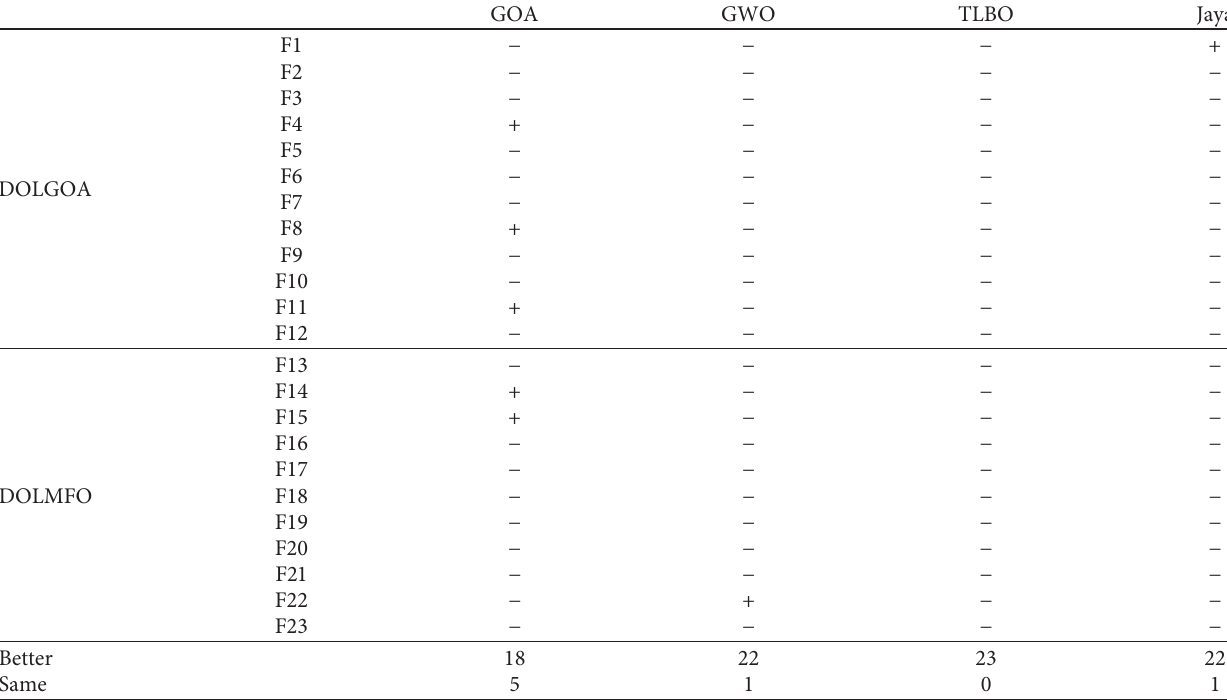
Figure 4: The convergence trends of all algorithms on hybrid and composition functions. Table 7: The P values of DOLGOA and other